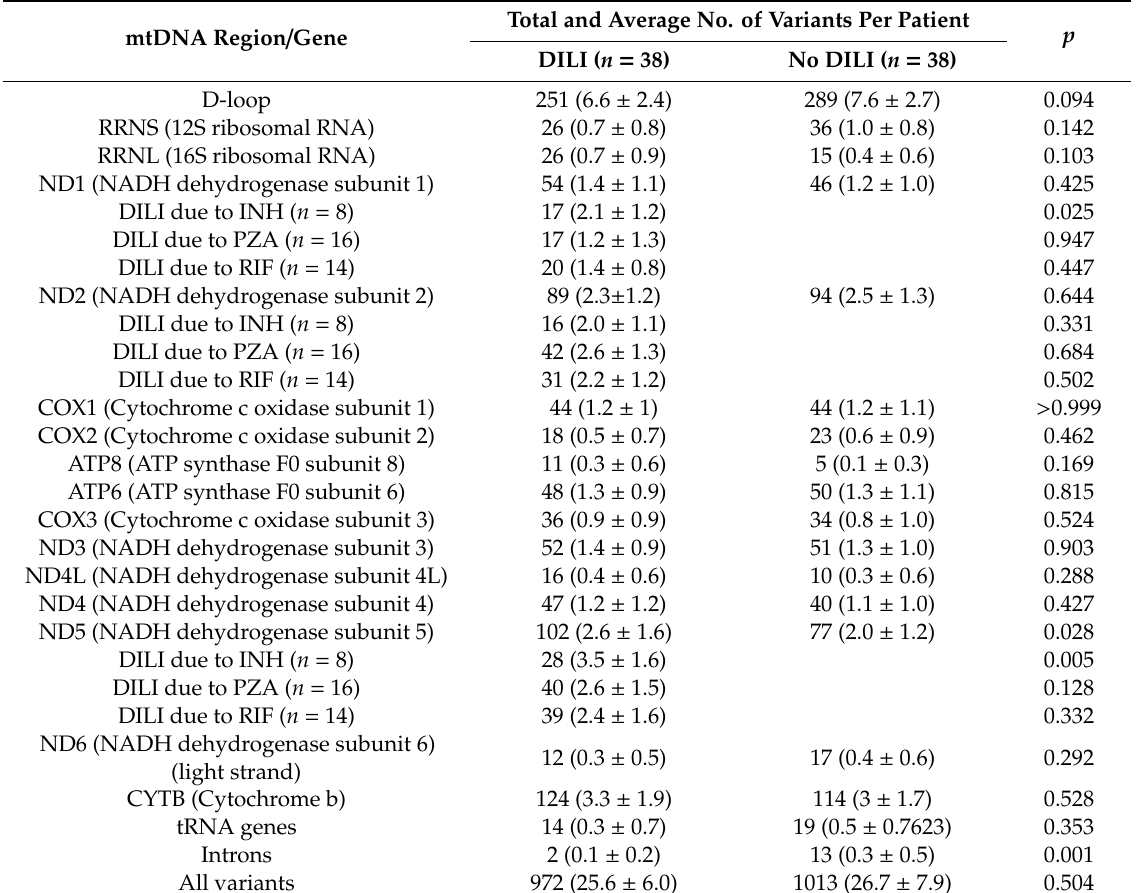
Table 2. Total and average number of variants per patient in each mitochondrial mtDNA gene for TB patients with DILI ( n = 38) and without DILI ( n =